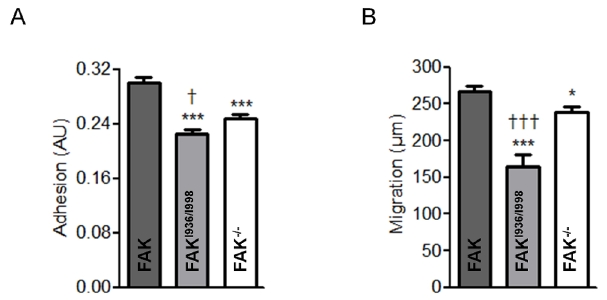
Figure 5. Effect of FAK I936/I998 expression on adhesion and migration. (A) For adhesion assay, cells were seeded in fibronectin- coated wells and allowed to adhere for 1 h before quantification. (P , 0.0001, F=28.96; 3 independent experiments done in sextupli- cates). ***p , 0.0001 versus FAK cells, { p , 0.02 versus FAK -/- cells. (B) For migration assays, confluent cell monolayers were wounded and cells were allowed to migrate for 8 h. Images were taken at t=0 and t=8 h, and the distance covered by migrated cells was evaluated. (P , 0.0001, F=21.57; 3 independent experiments done in triplicates). ***p , 0.0001 versus FAK cells, *p , 0.02 versus FAK cells, {{ p , 0.005 versus FAK -/-